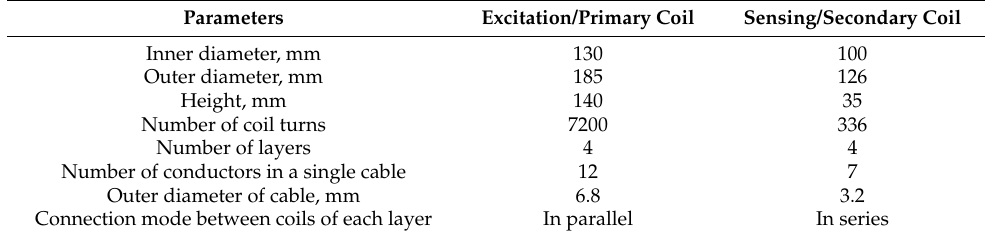
Table 1. Technical parameters of the coil sensor and the Hall sensor.